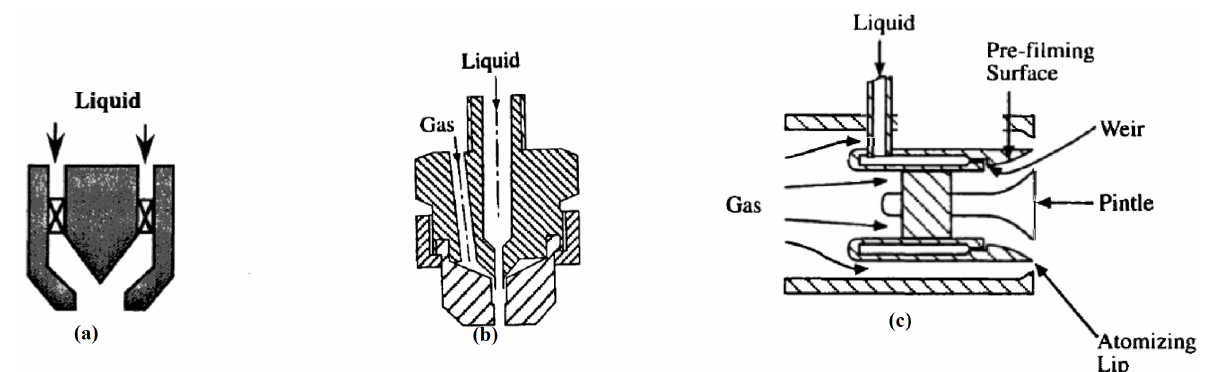
Figure 2. Schematic of ( a ) simplex pressure nozzle, ( b ) internally-mixed twin-fluid nozzle, and ( c ) prefilming twin-fluid nozzle [9,75].